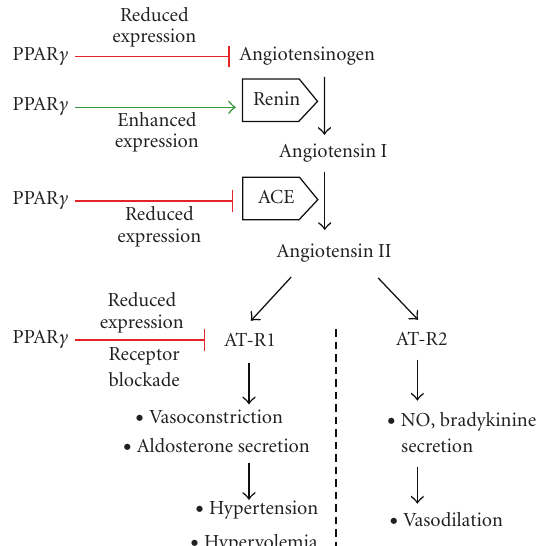
Figure 2: Role of PPAR γ in the modulation of the RAAS cascade. Gene expression of RAAS molecules is modulated by PPAR γ. Although renin production is facilitated by PPAR γ activation, the hypertensive e ff ects of RAAS activation are attenuated by PPAR γ ligands, since these strongly reduce Ang II levels, ACE and AT-R1 gene expression. Telmisartan also exerts AT-R1 blocking properties. Simultaneously with blockade of AT-R1, the beneficial vasodilator e ff ects of AT-R2 activation become